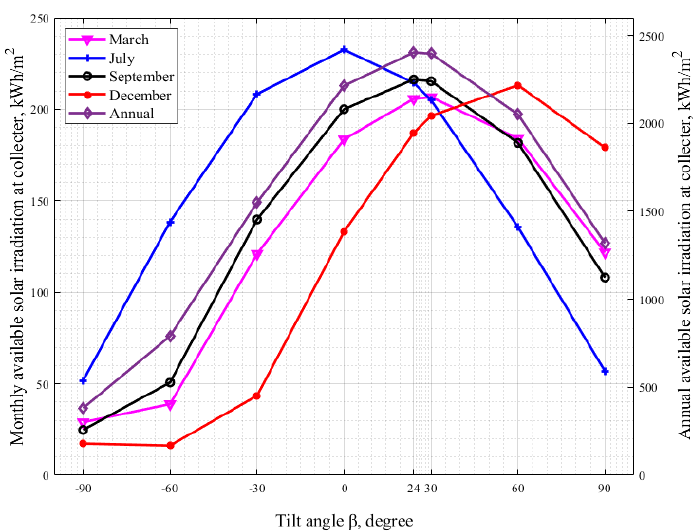
Figure 9. The effect of tilt of the solar irradiance as a function of collector tilt